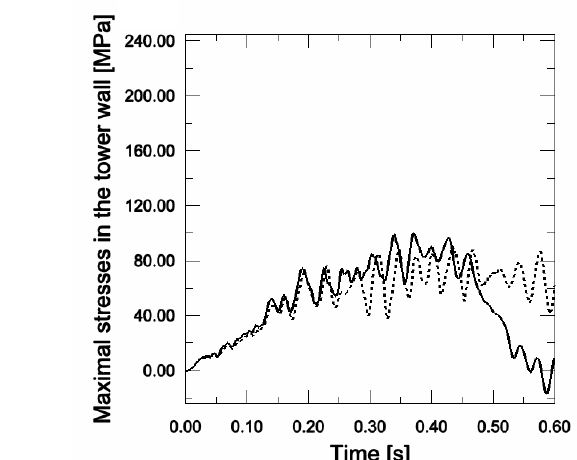
tower, which is achieved by applying initial pressure higher than p min 0 for each impact. Front tower wall is